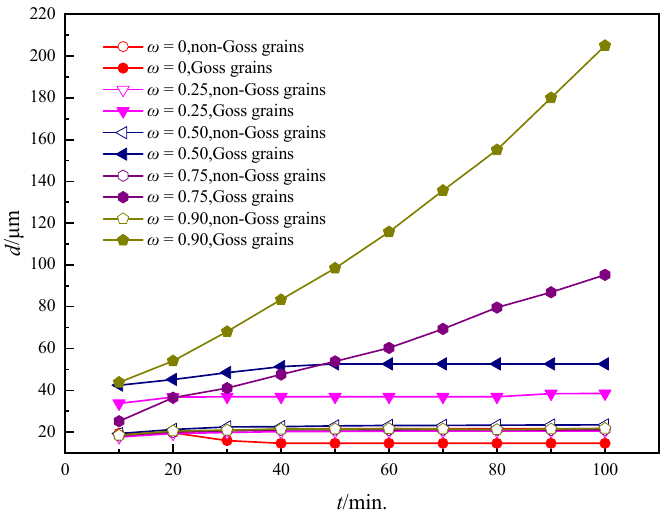
Figure 10. The kinetic curves of growth for Goss and non-Goss grains under different ω s where T = 1273 K and c = 0.10%.